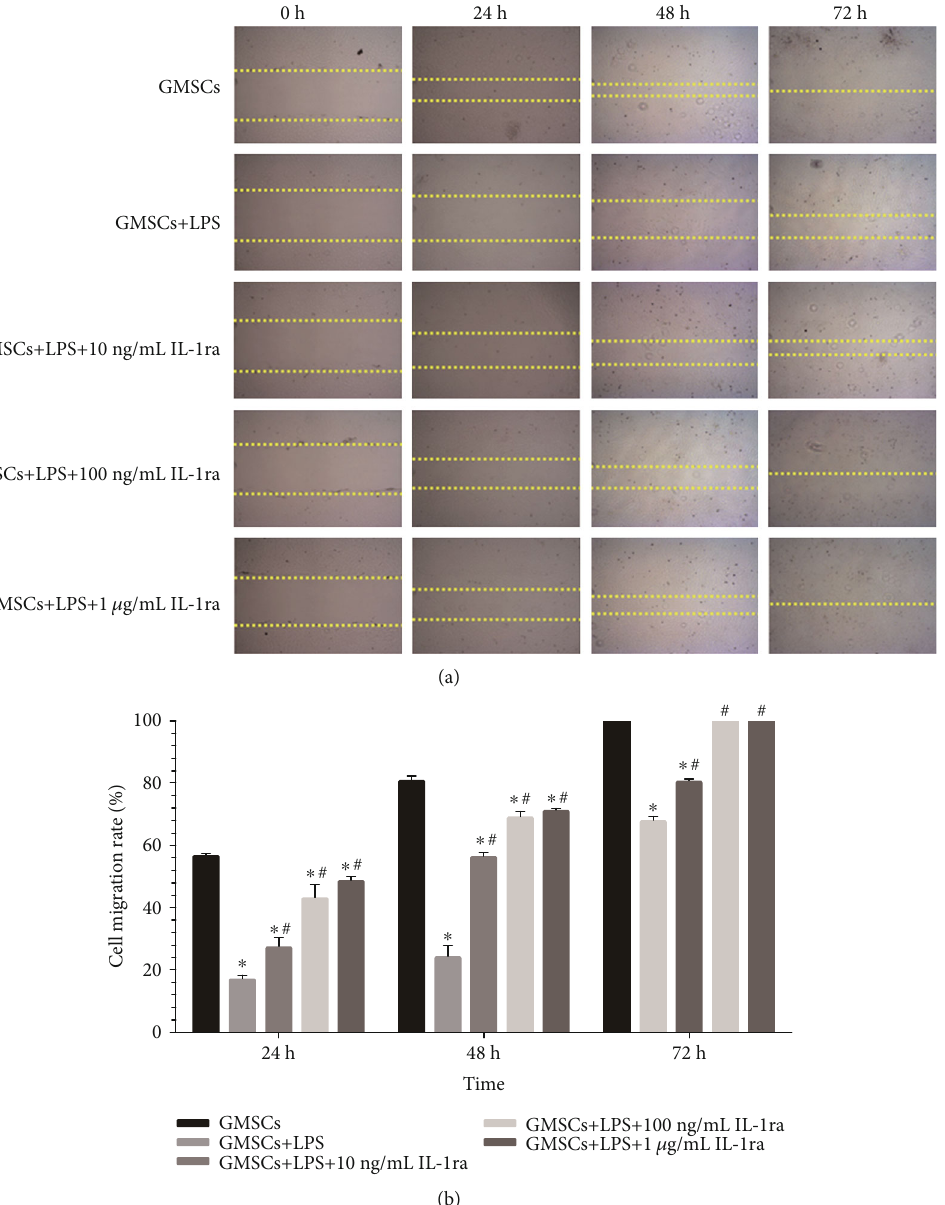
Figure 6: E ff ect of P. gingivalis -LPS and IL-1ra on rGMSC migration capacity at 24, 48, and 72 hours. (a) Migration of rGMSCs to cover the scratch area. (b) Cell migration rate in the control group, in fl ammatory group, and anti-in fl ammatory groups at di ff erent time points. ∗ P < 0 : 05 vs. GMSCs; # P < 0 : 05 vs.